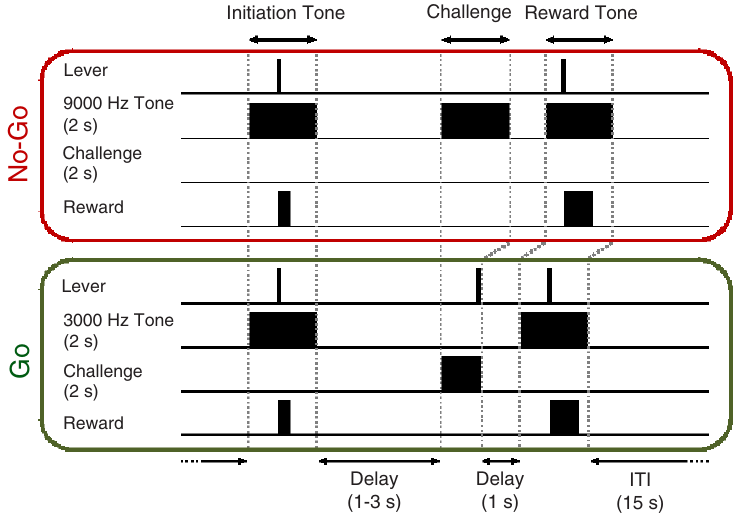
Figure 1. Schematic showing the head-fixed Go/No Go task under a No-Go trial and Go trial. Lever presses, initiation tone, challenge period, reward tone, and sucrose reward delivery components are shown for both trials. The black boxes represent the relative timing of the rat’s response (lever press) in response to the auditory cues. ITI: inter-trial